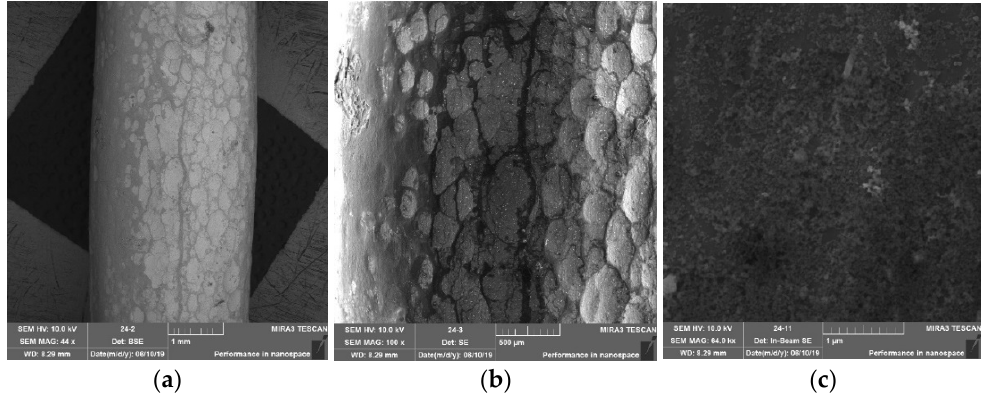
Figure 14. SEM micrographs of the surface of a sample containing one layer of protective coating applied by immersion in SiO 2 nanoparticles sol. ( a ) zoom ×42; ( b ) zoom ×32,000; ( c ) zoom ×64,000.